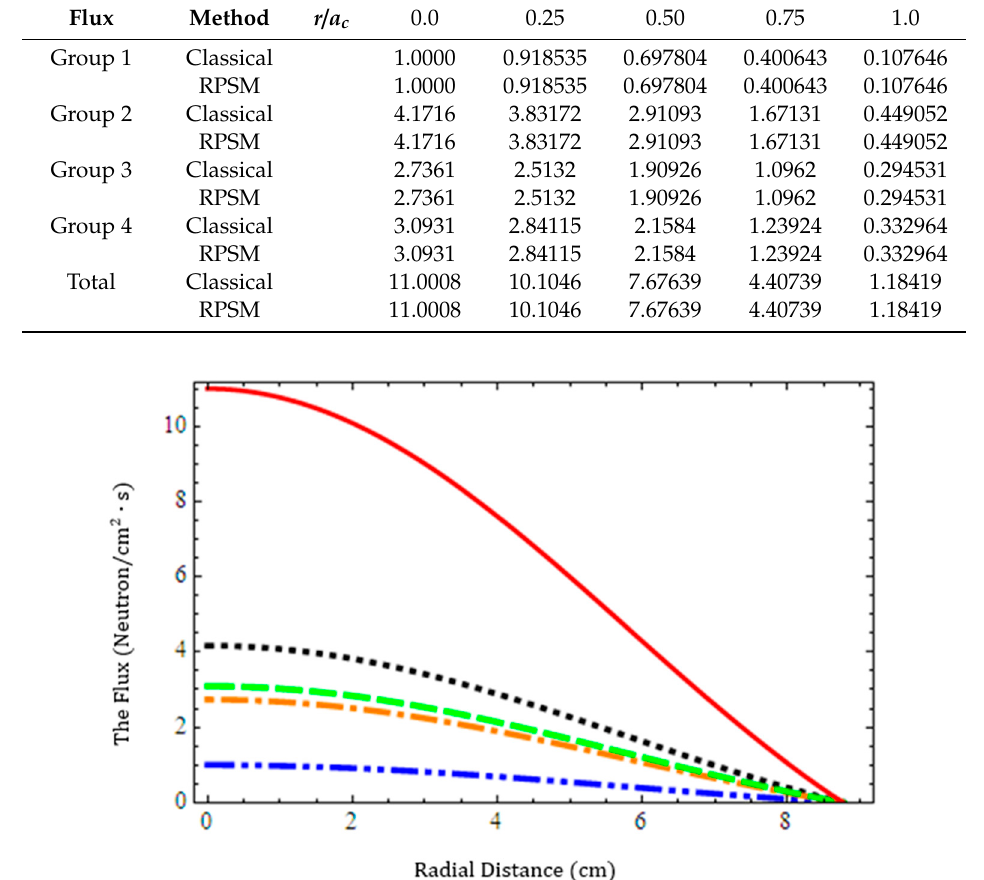
Figure 4. Four energy groups fluxes and total flux for a spherical reactor. Dotted-dotted dashed line: ∅ ( r ) , Dotted line: ∅ ( r ) , Dotted dashed line: ∅ ( r ) , Dashed line: ∅ ( r ) , Solid line: Total fluxes. 2 3 1 4 RPSM results (as well as for classical method) for multi-energy groups of neutrons system in spherical reactor assure and improve the calculations of that of two energy groups of